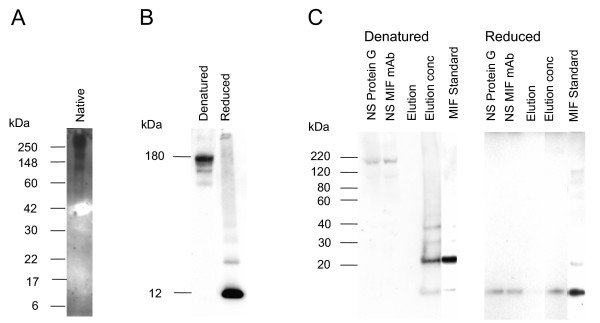
MIF Western blot of serum proteins. A. Native serum MIF – Serum was diluted 1:20 in PBS and proteins were separated under native conditions then analyzed for MIF by Western blot analysis. Under native conditions, a broad band between 150 – 500 kDa was detected. B. Denatured and reduced serum MIF – Serum was diluted as in A and proteins separated under denaturing or reducing conditions. Denaturing conditions resulted in a single prominent band at 180 kDa and some minor bands between 80 and 120 kDa. Under reducing conditions, a single prominent 12-kDa band and a minor band at 24 kDa were observed. C. mAb Affinity purified serum MIF – MIF containing serum proteins were purified by sequential affinity chromatography through Protein G agarose, followed by MIF mAb affinity chromatography. Nonsticking proteins as well as elution fractions were separated by NuPAGE gel electrophoresis under denaturing or reducing conditions, transferred to PVDF and MIF containing bands identified using a polyclonal antibody (R&D Systems, 1:1000 dilution). Lanes left to right: NS Protein G – non-sticking fraction from Protein G column; NS MIF mAb – non-sticking fraction from MIF monoclonal antibody column; Elution – third elution fraction; Elution conc – third elution fraction concentrated 800 fold; MIF standard – 7.5 ng of recombinant MIF protein. Numbers and lines to the left of each Western blot indicate location of molecular weight markers.